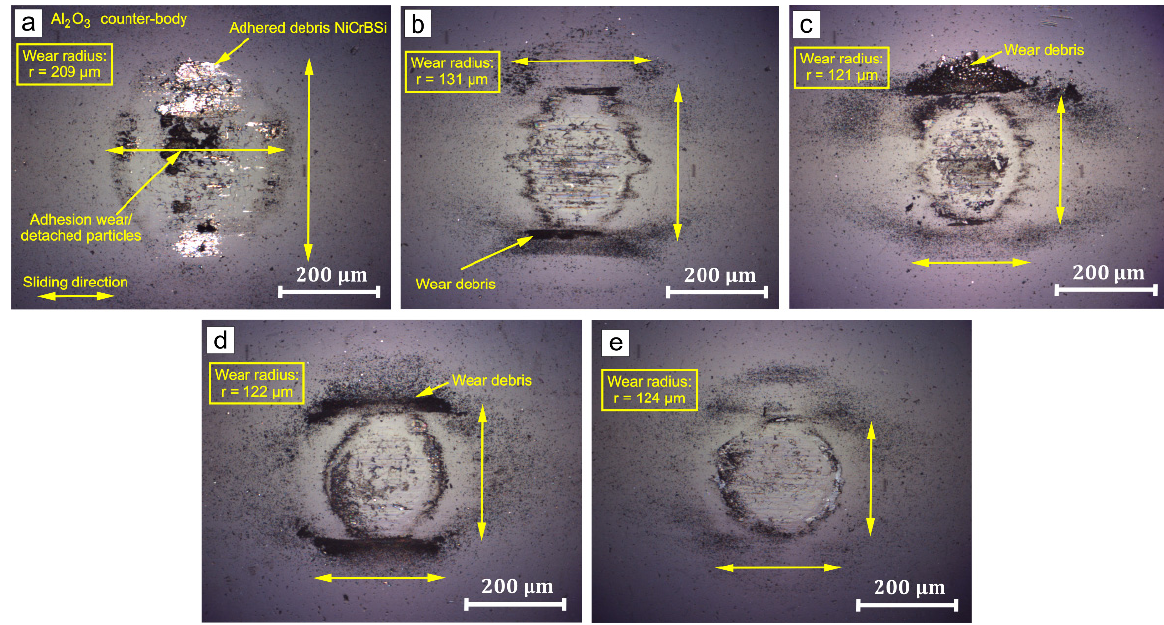
Figure 10. Coefficient of friction for the: ( a ) NiCrBSi and WC-Co and ( b ) NiCrBSi + 30, 40, 50 wt.% WC-12Co.